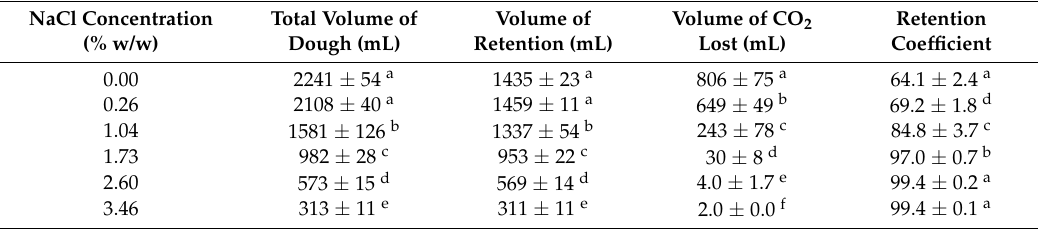
Table 2. Yeast performance in wheat dough with different NaCl concentrations during 3 h fermentation.